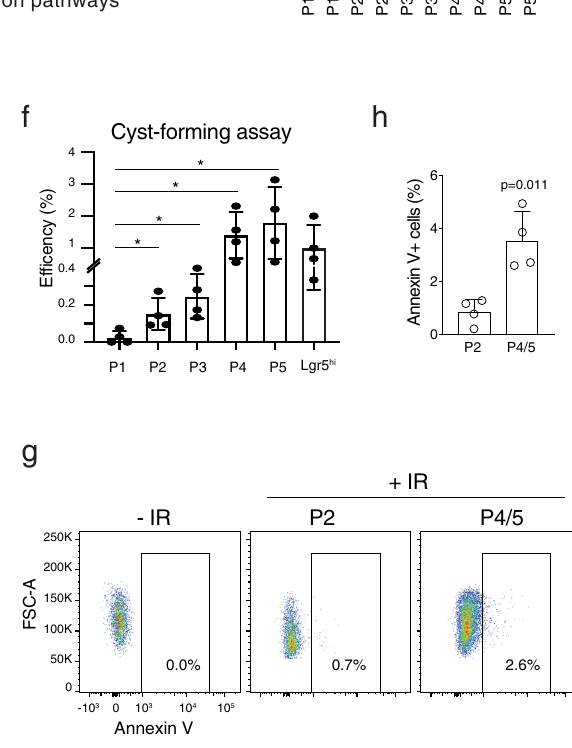
Immunoprecipitation of FLAG-tagged proteins, PhosTag TM SDS-PAGE . For the immunoprecipitation of FLAG-tagged proteins from mammalian cells, proteins were expressed from CSII-EF-mCherry-P2A3F-Venus plasmid constructs. Immunoprecipitation was performed according to manufacturer ’ s protocol (Sigma FLAGIPT1-1KT, FLAG immunoprecipitation Kit). Protein extracts were separated using Phos-tag SDS 12.5% gels following manufacturers ’ protocol (Wako 195- 17991). Both immunoprecipitation as well as western blotting were performed using anti-FLAG-tag antibodies. Protein extracts were boiled 5 min in SDS loading buffer containing beta-mercaptoethanol and loaded onto a 12% bisAcrylamide gel. The gel was run at 150V for 30 min and wet transferred onto a PVDF